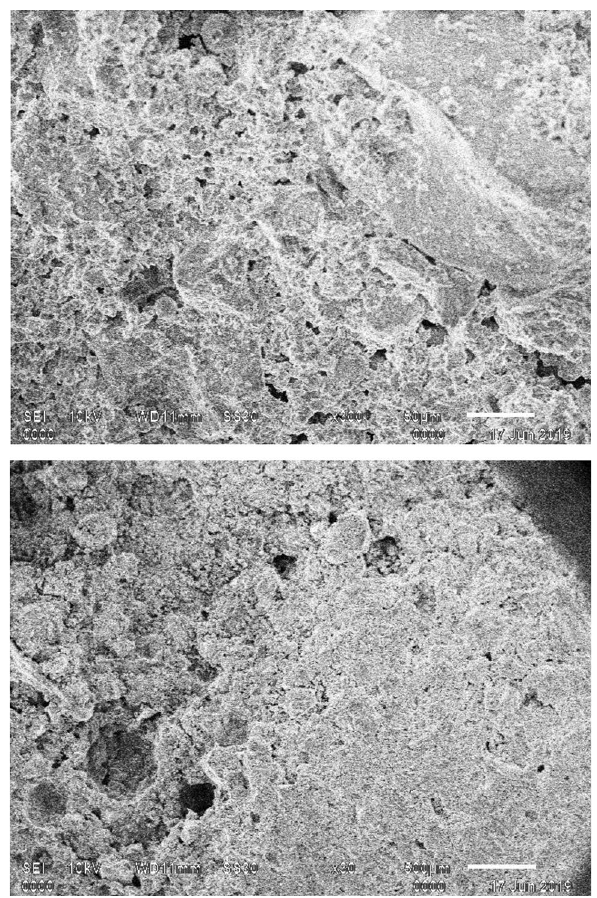
Figure 11. SEM micrograph of the fractured verification CBC samples (Corner) with higher wood content at the